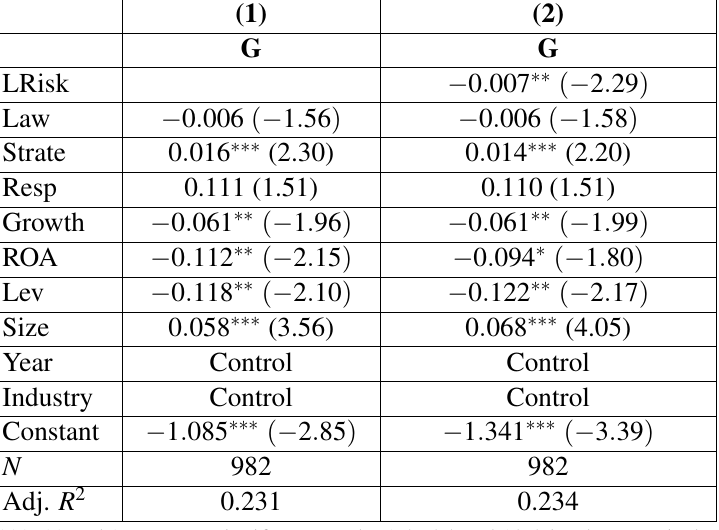
Table 4 Civil litigation and corporate governance.